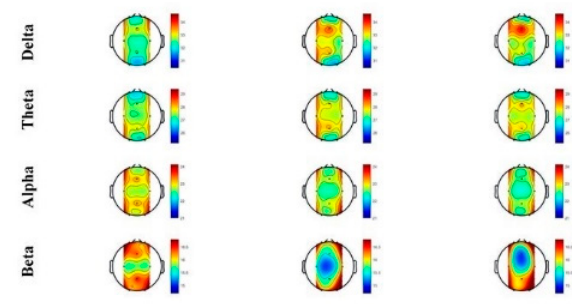
Figure 6. Topography of relative power in three conditions: rest ( upper ), slow-rate task ( middle ), and fast-rate task ( bottom ). 3.4. Fast-Task-Related Relative Spectral Power The PSD on five brain regions in the fast-rate task condition of the two groups (all ADHD versus TD) as well as the three groups (ADHD-H versus ADHD-L versus TD) were compared (Supplementary Table S3). Table 3 and Figure 6 present the significant results from the analysis of between-group differences in the fast-rate task-related PSD. A significance in which the ADHD-L group had a significantly higher value of delta and trending lower values of beta on Pz than the TD group was observed ( p = 0.011, p = 0.039, respectively). Notably, the ADHD-L group had a higher value of delta and theta as well as lower values of alpha and beta on Pz than the ADHD-H group ( p = 0.011, p = 0.031, p = 0.008, p = 0.002, respectively), which indicated apparent ADHD heterogeneity.